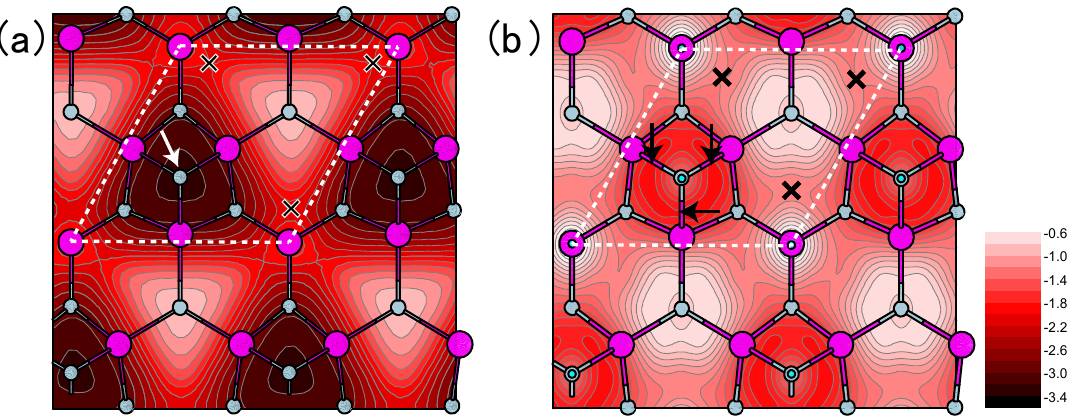
( a ) an N adatom and ( b ) H atoms. Large, small, and tiny circles represent Al, N, and H atoms, respectively. Each contour line in ( a ) and ( b ) represents an energy step of 0.1 and 0.2 eV, respectively. The dashed rectangles denote the surface unit cells. Arrows and crosses in the unit cell represent minima and PES saddle points,